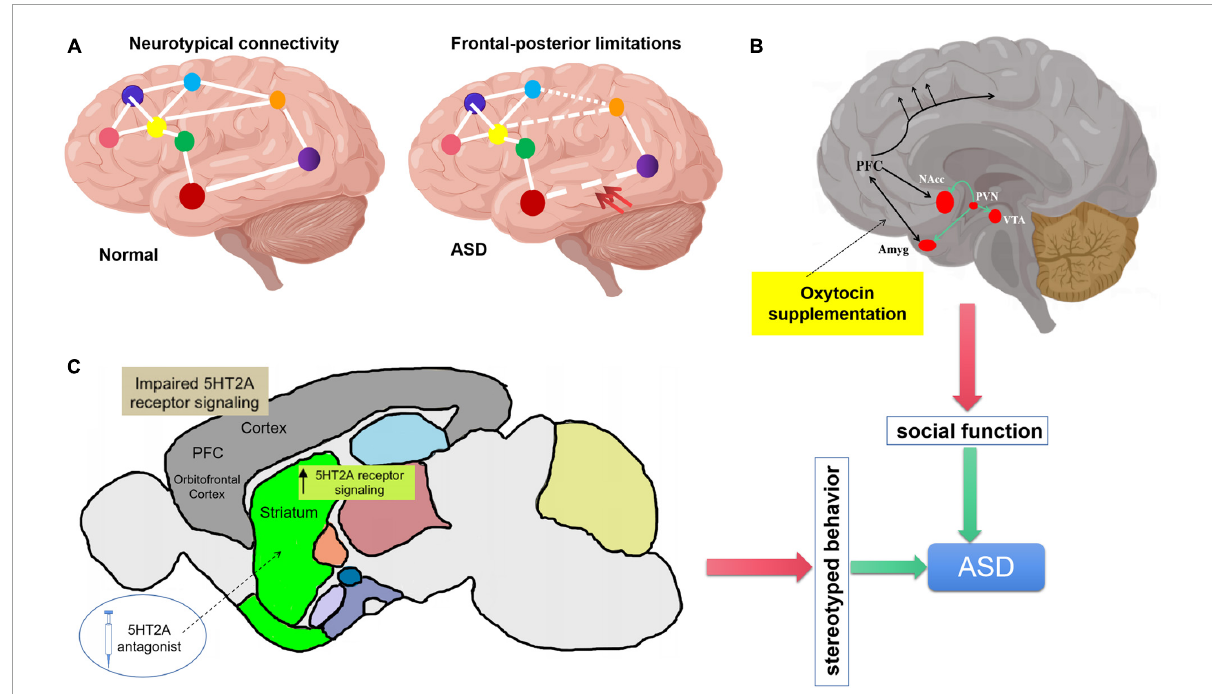
FIGURE1 Regulation of oxytocin and serotonin on autism spectrum disorder (ASD) core symptoms. (A) Underconnecticity hypothesis, frontal-posterior underconnectivity in ASD (the double red arrow indicates) could explain the social cognitive impairment. (B) Schematic representation of oxytocinergic (green lines). OXT is synthesized in paraventricular nucleus (PVN), projects to key limbic sites (VTA, NAcc, and Amyg). (C) Cortico-striatal projections induce repetitive behavior. Elevation of serotonin 5HT 2A receptor signaling in the dorsomedial striatum gives rise to stereotypic behaviors. Application of serotonin 5HT 2A antagonist in the dorsomedial striatum also results in the rescue of repetitive behavior. 5HT 2A , 5-hydroxy-tryptamine receptor 2A